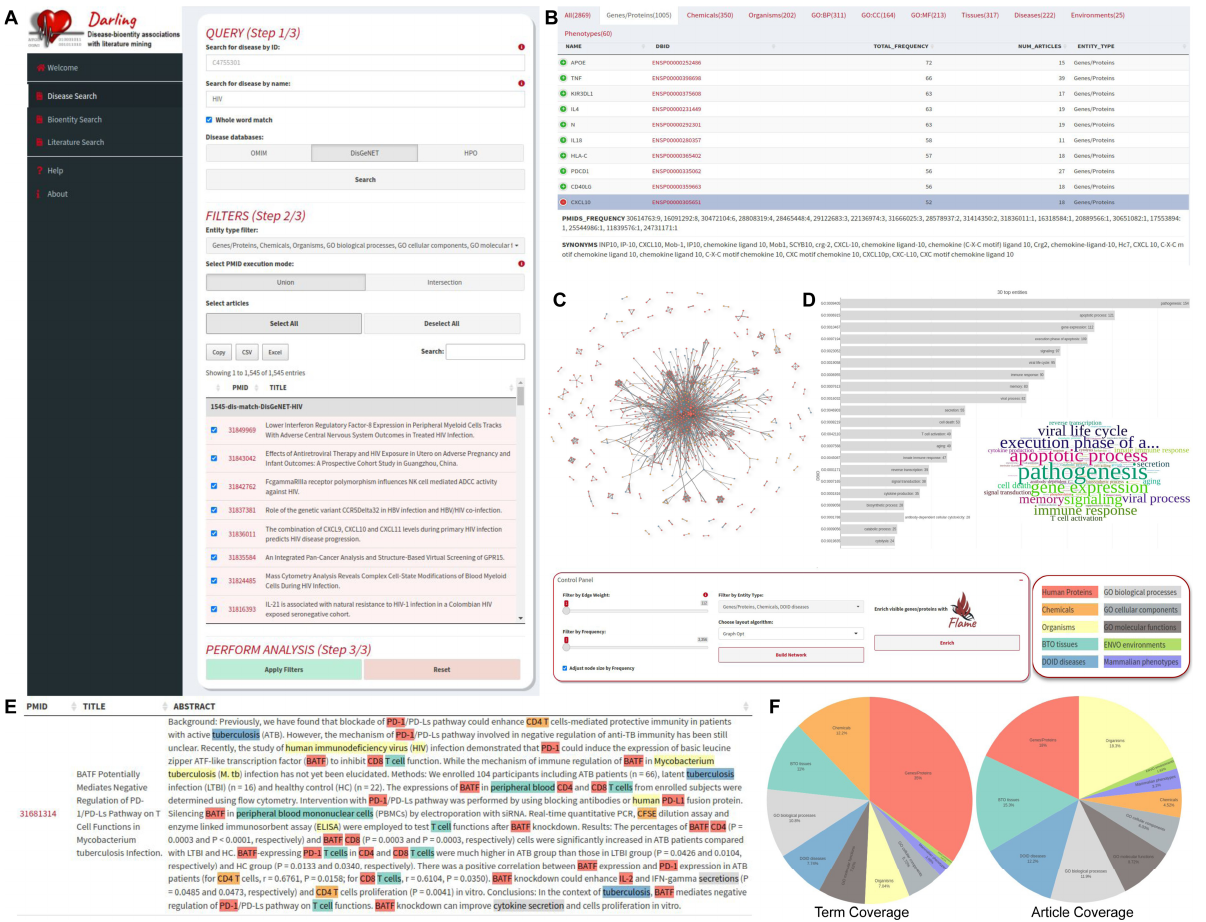
Figure 2. The Darling Graphical User Interface of Darling. ( A ) The input form of the Disease Search query. Users can perform searches using a disease’s name or database identifier, against the data retrieved from OMIM, HPO or DisGeNET. In the example, the term “HIV” is searched against DisGeNET. The search form initially returns the publications associated with the disease. Users can then choose the publications and entity types of their interest and perform an analysis, using the form elements at the bottom of the page. ( B ) Excerpts of the results retrieved for the search. A total of 2869 entities have been retrieved and organized in distinct categories. For each term, its database identifier, canonical name, synonym terms and associated PubMed identifiers (PMIDs) are shown; in addition, the frequency of the terms, both total and for each distinct publication, is calculated. ( C ) A knowledge-based association network generated by the search results. Users can adjust the elements of the network and select from a list of different visualization layouts. ( D ) Bar-plot (left) and word cloud (right) representations of the most frequent GO biological processes associated with HIV. ( E ) A graphical representation of one of the publication abstracts, with extracted bioentities highlighted in color. ( F ) Pie charts of the overall coverage of terms and articles retrieved for every bioentity